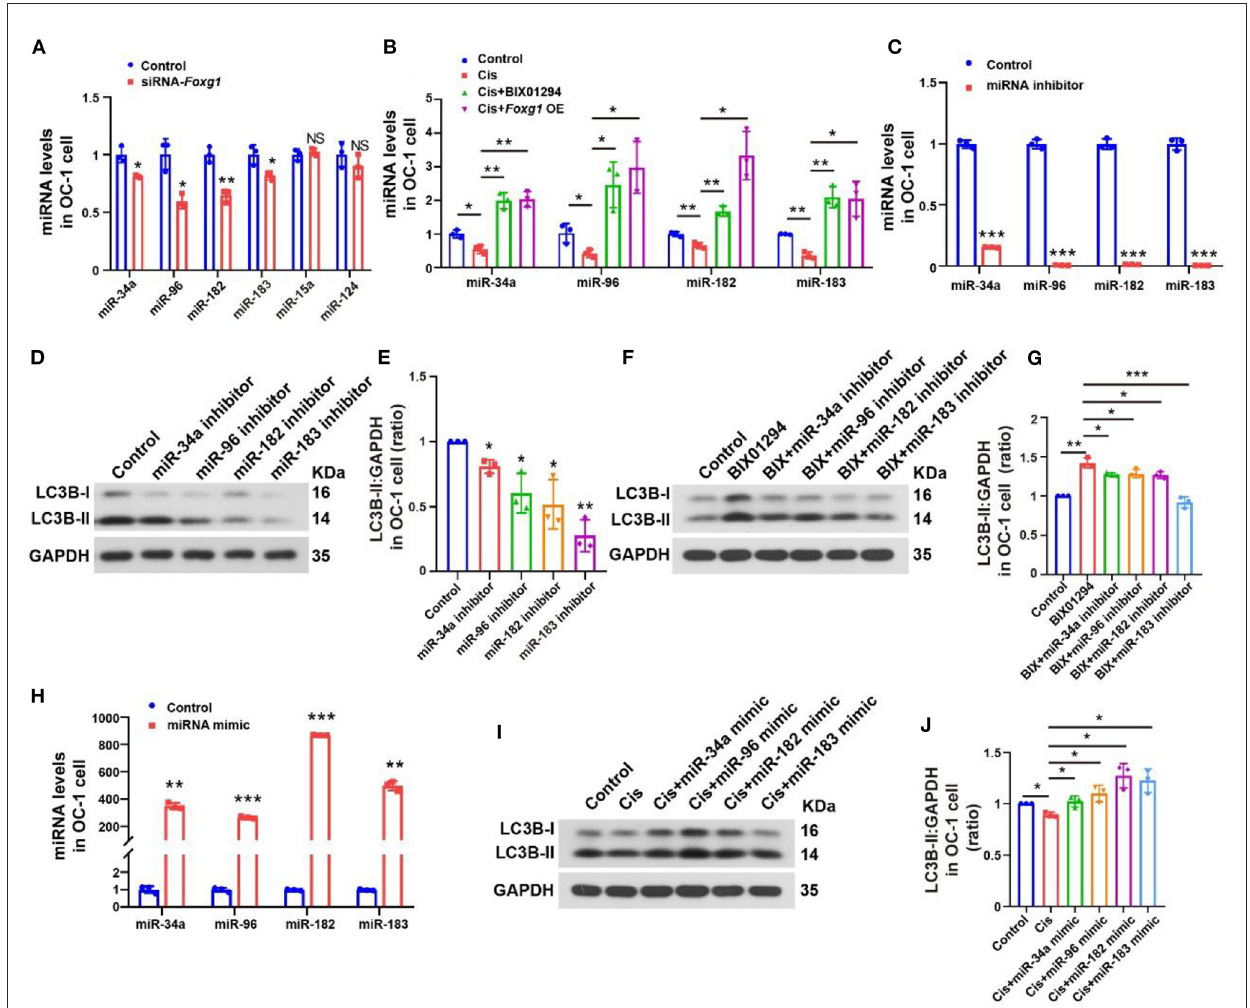
FIGURE7 Autophagy levels of OC-1 cells change through the regulation of miR-34a, miR-96, miR-182, and miR-183 expression. (A) rt-PCR of changes in miR-34a, miR-96, miR-182, and miR-183 expression with Foxg1 knockdown (B) rt-PCR of the expression in miR-34a, miR-96, miR-182, and miR-183 changes after cisplatin treatment with BIX01294 pre-treatment or Foxg1 overexpression. (C) rt-PCR of miR-34a, miR-96, miR-182, and miR-183 expression inhibition efficiency. (D) Western blotting of changes in LC3B levels after miR-34a, miR-96, miR-182, and miR-183 inhibition. (E) Quantification of the western blotting in (F) . (F) Western blotting of changes in LC3B levels after BIX01294 treatment with miR-34a, miR-96, miR-182, and miR-183 inhibition. (G) Quantification of the western blotting in (F) . (H) rt-PCR of miRNA mimic efficiency for enhancing miR-34a, miR-96, miR-182, and miR-183 expression. (I) Western blotting of changes in LC3B levels after cisplatin treatment with miR-34a, miR-96, miR-182, and miR-183 mimics. (J) Quantification of the western blotting in (F) . * p < 0.05, ** p < 0.01, *** p <